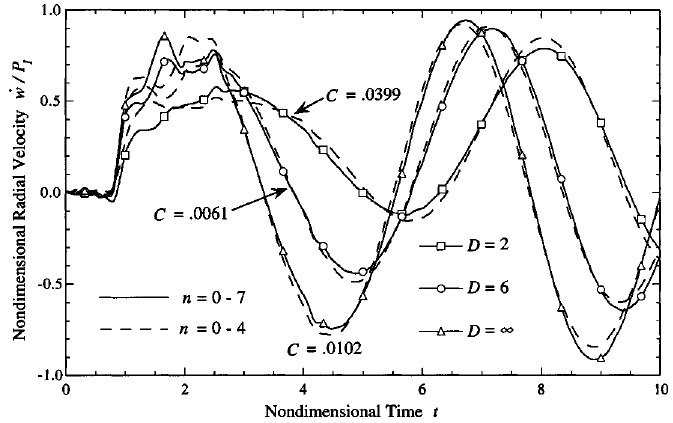
Fig. 9. Shell radial-velocity histories at (cid:18) = 0 for an empty spherical shell excited by spherical step-exponential waves ( (cid:12) = 2).